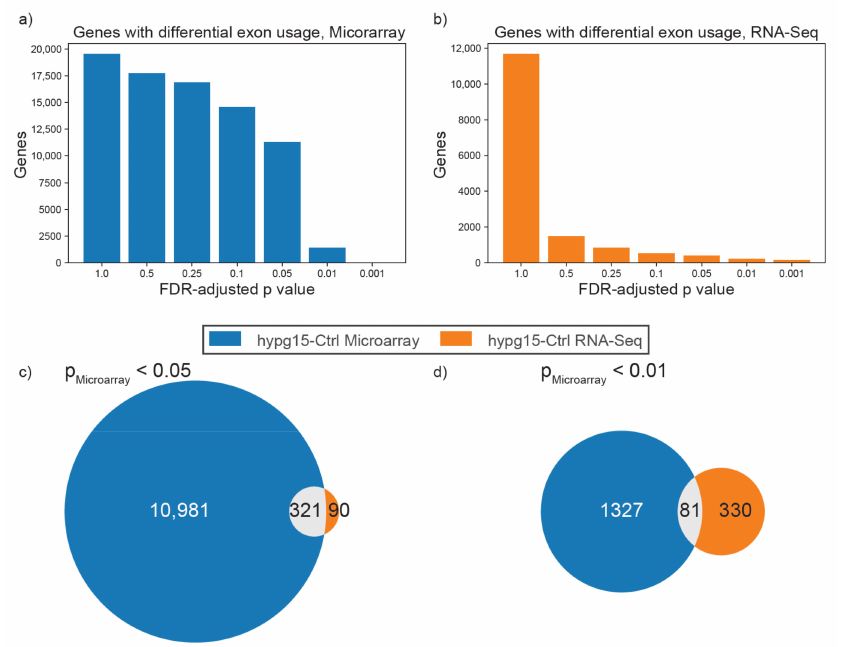
Figure 3. Differential exon usage (DEU)/alternative splicing detection for both technologies. ( a ) Visualization of the number of genes reported that have differential exon usage for the microarray data set at various FDR-adjusted p -value cutoffs. DEU detection was performed by the Affymetrix Transcriptome Analysis Console (TAC). ( b ) Visualization of how many genes are reported to have differential exon usage for the RNA-Seq data set. DEU detection was performed by the DEXSeq pipeline. ( c , d ) Overlap of detected DEU genes at FDR-adjusted p -value of 0.05 for RNA-Seq and 0.05/0.01 for microarray TAC. A list of all significant genes that overlap in 3c can be found in the supplement (Table